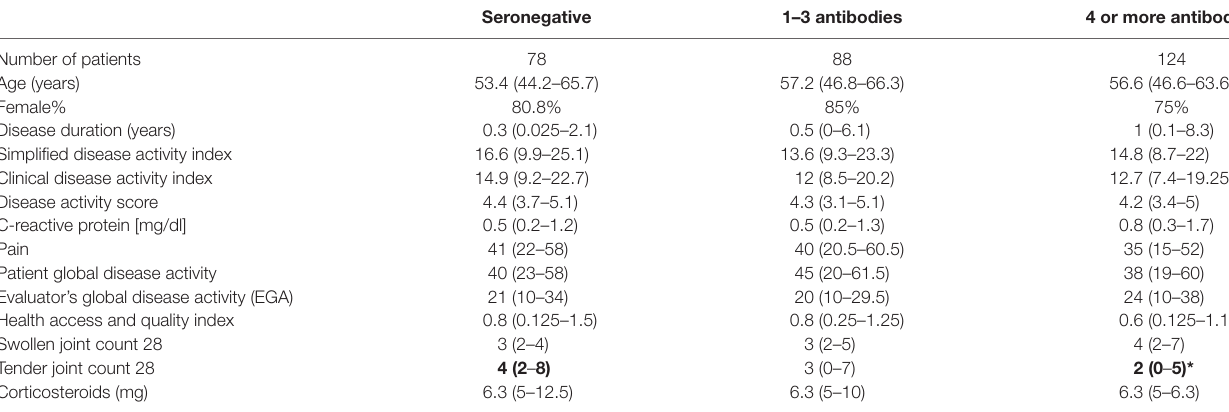
TaBle 4 | Clinical parameters of rheumatoid arthritis patients with none, 1–3, and 4 or more positive Igs. seronegative 1–3 antibodies 4 or more antibodies Number of